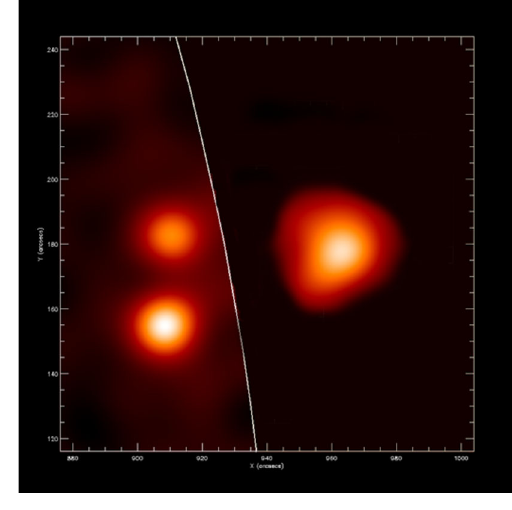
Fig. 10 Reconstructed (CLEAN) image of SOL2006-07-13T14 in hard X-rays observed by the RHESSI satellite. The curved line indicates the limb of the photosphere. The displayed energy range 12–50 keV is dominated by the low energies, where the coronal source ( right ) prevails. Two footpoints ( left ) are clearly visible on the disk. Image courtesy of Marina Battaglia, for details see Battaglia and Benz